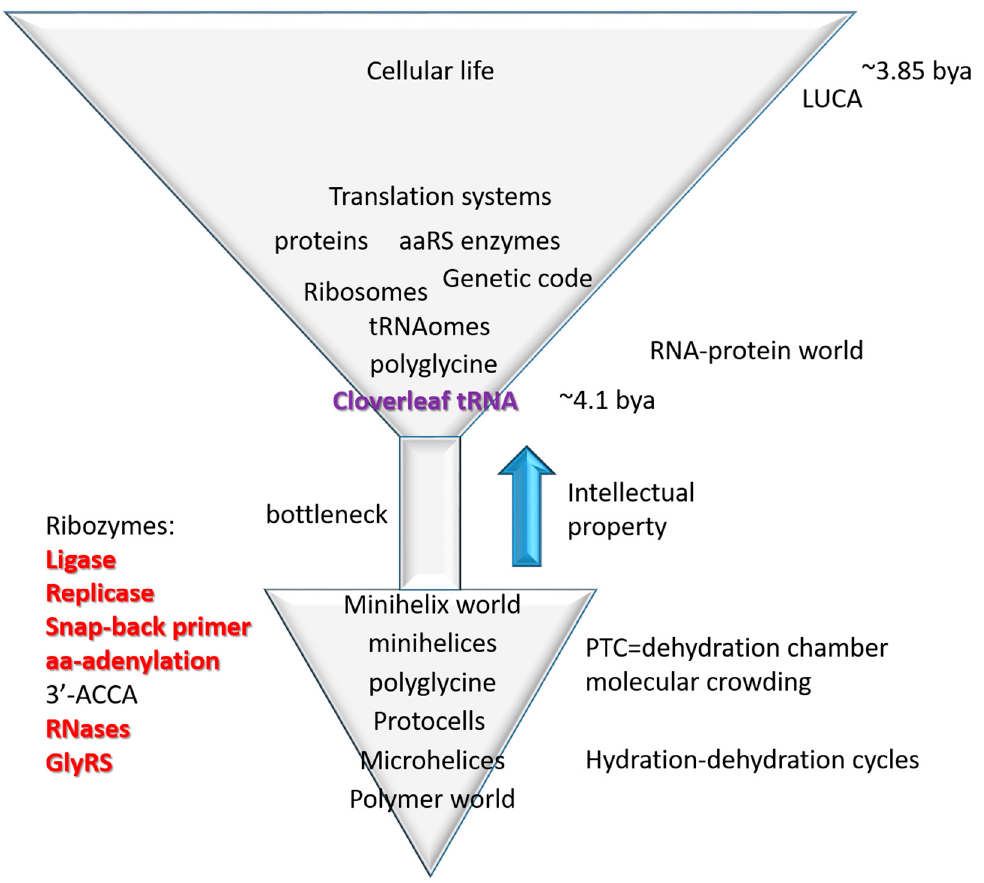
Figure 7. Evolution of translation systems. A simple model for the inanimate → animate transition based on the evolution of cloverleaf tRNA from sequence repeats and 31-nt minihelices including stem-loop-stems (see Figure 1). See the text for details.